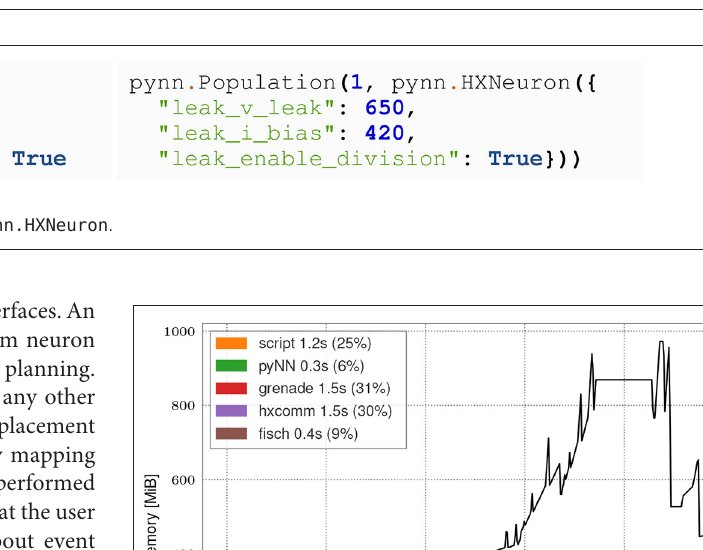
FIGURE 6 | Abstract network notation. Population A consisting of five neurons is connected to population B consisting of four neurons via projection AB. (Left) Abstract network. (Right) Placed and routed on the hardware, where the projection AB consists of synapses in the two-dimensional synapse matrix and the populations A and B are located in the neuron row, compare Figure 1D .